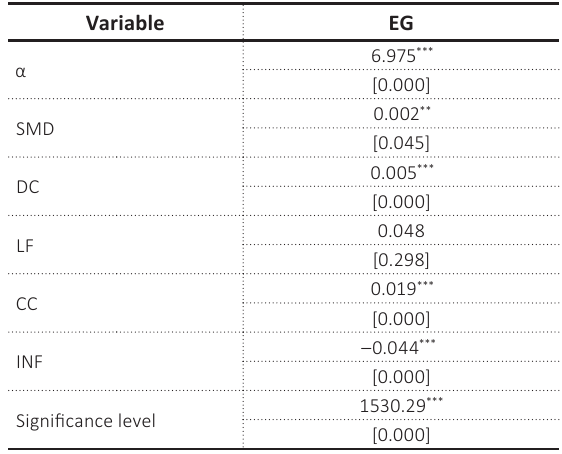
Table 6. Results using the GMM